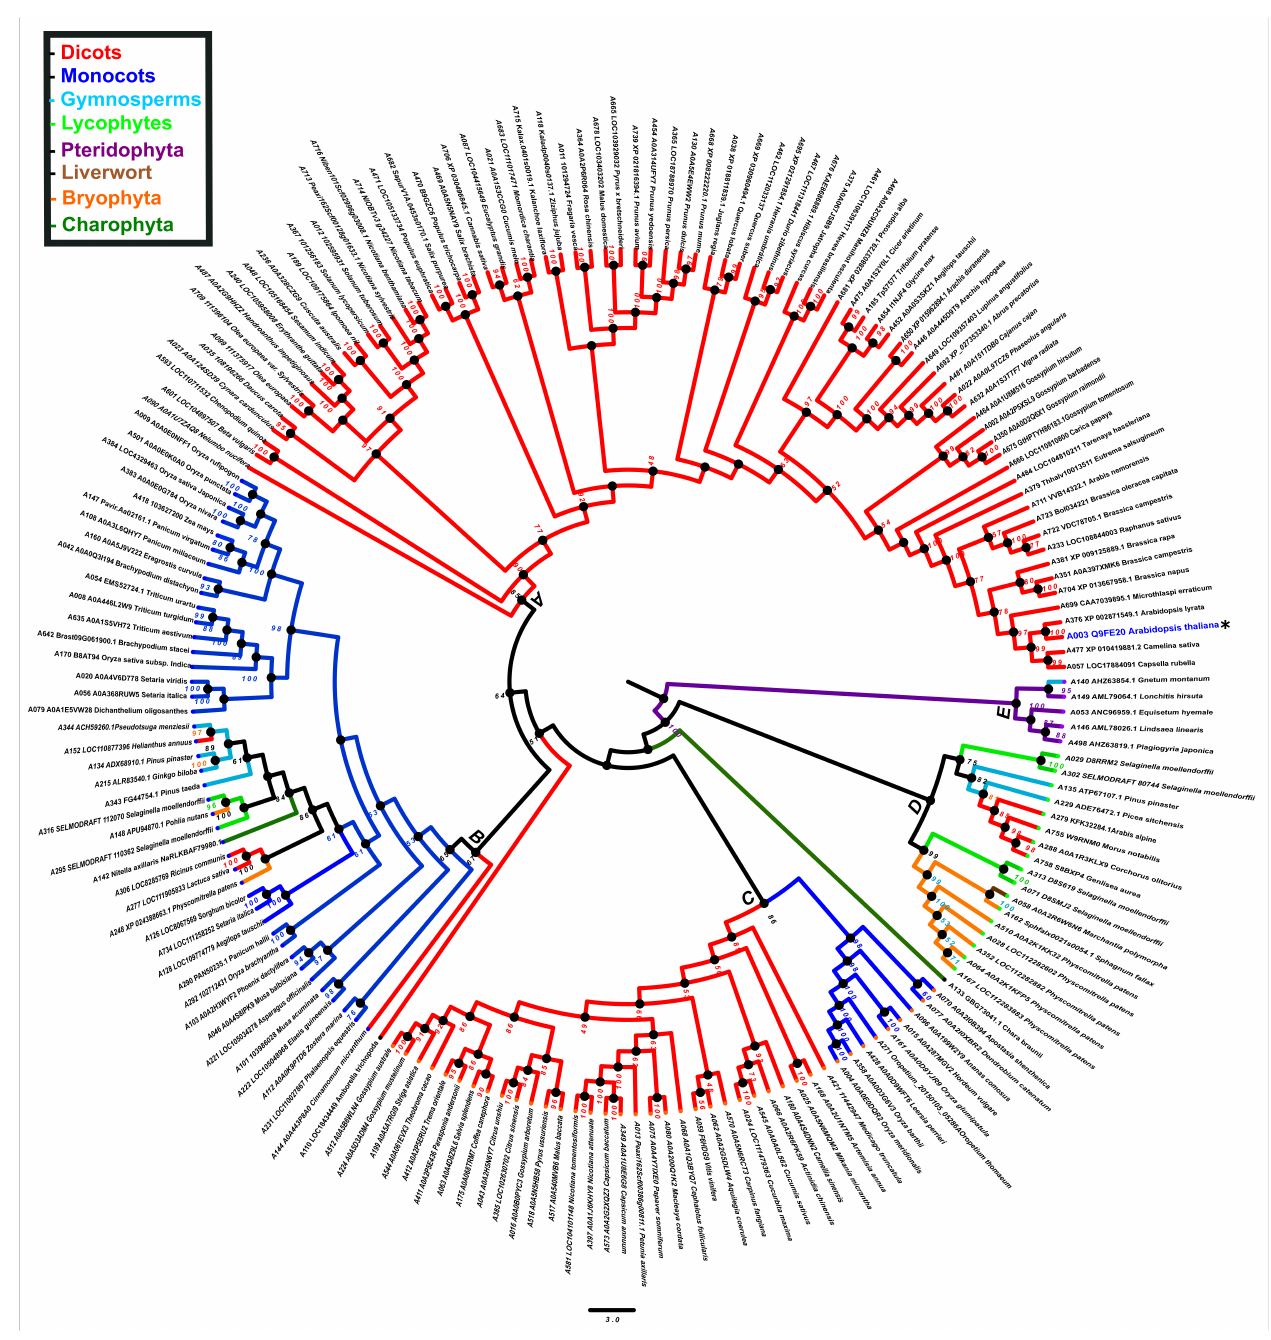
Figure 6. Phylogenetic analysis of PBS1 orthologs in terrestrial plants. A total of 182 amino acid sequences from Arabidopsis PBS1 orthologs were obtained from different databases and aligned using ClustalW. A maximum likelihood phylogenetic tree was constructed based on the deduced amino acid sequences PBS1 proteins from several terrestrial plants. Red (clade A) indicates eudicots; blue (clade B and C), monocots; purple (clade E), pteridophytes; orange (clades B and D), bryophytes; dark green (clade B), charophytes; light blue (clades B, D and E), gymnosperms; light green (clades B and D) lycophytes and brown (clade D) liverwort. Position of Arabidopsis in the tree is indicated with asterisk (*) and blue